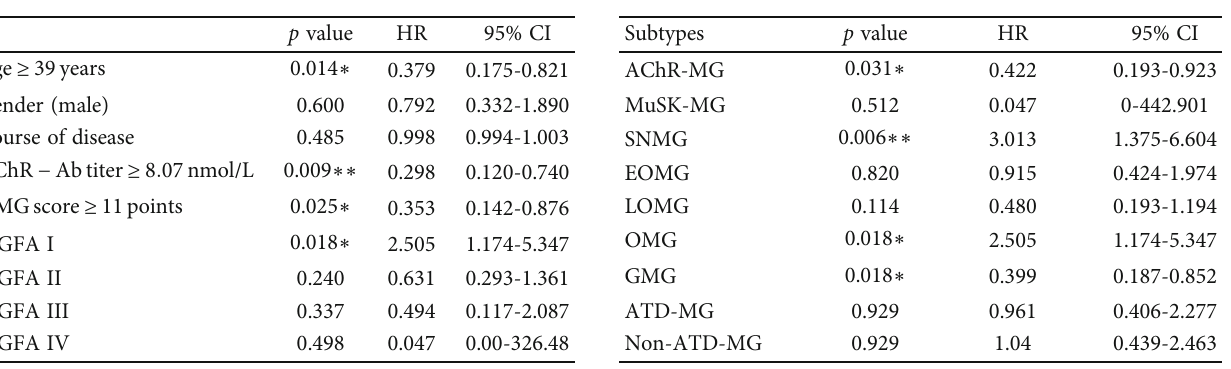
Note: the proportion of di ff erent MGFA PIS at each follow-up time point was compared by nonparametric Chi-square test. ∗ p < 0 : 05 ; ns: no signi fi cance. Table 4: Cox regression analysis of factors a ff ecting the response to tacrolimus.